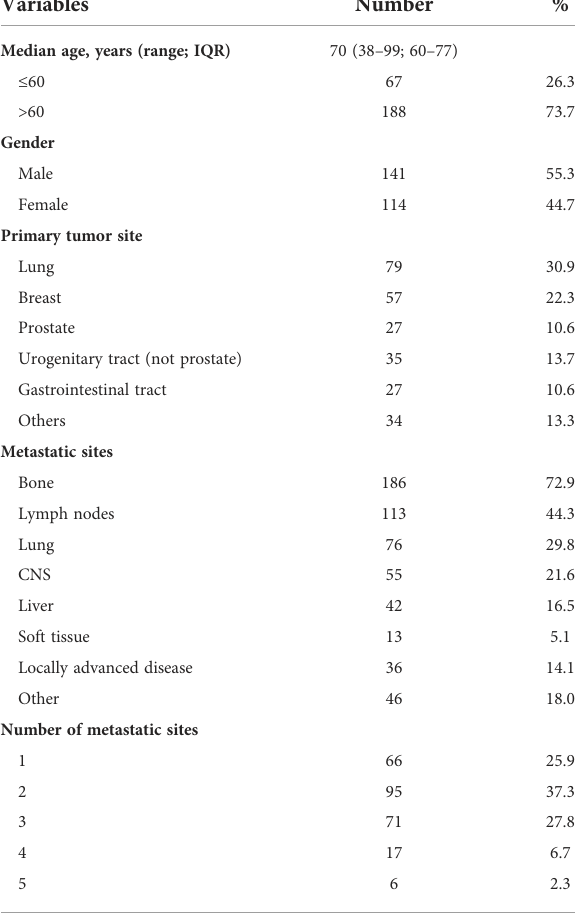
TABLE 1 Main clinical – biological charactestistics of 255 patients.